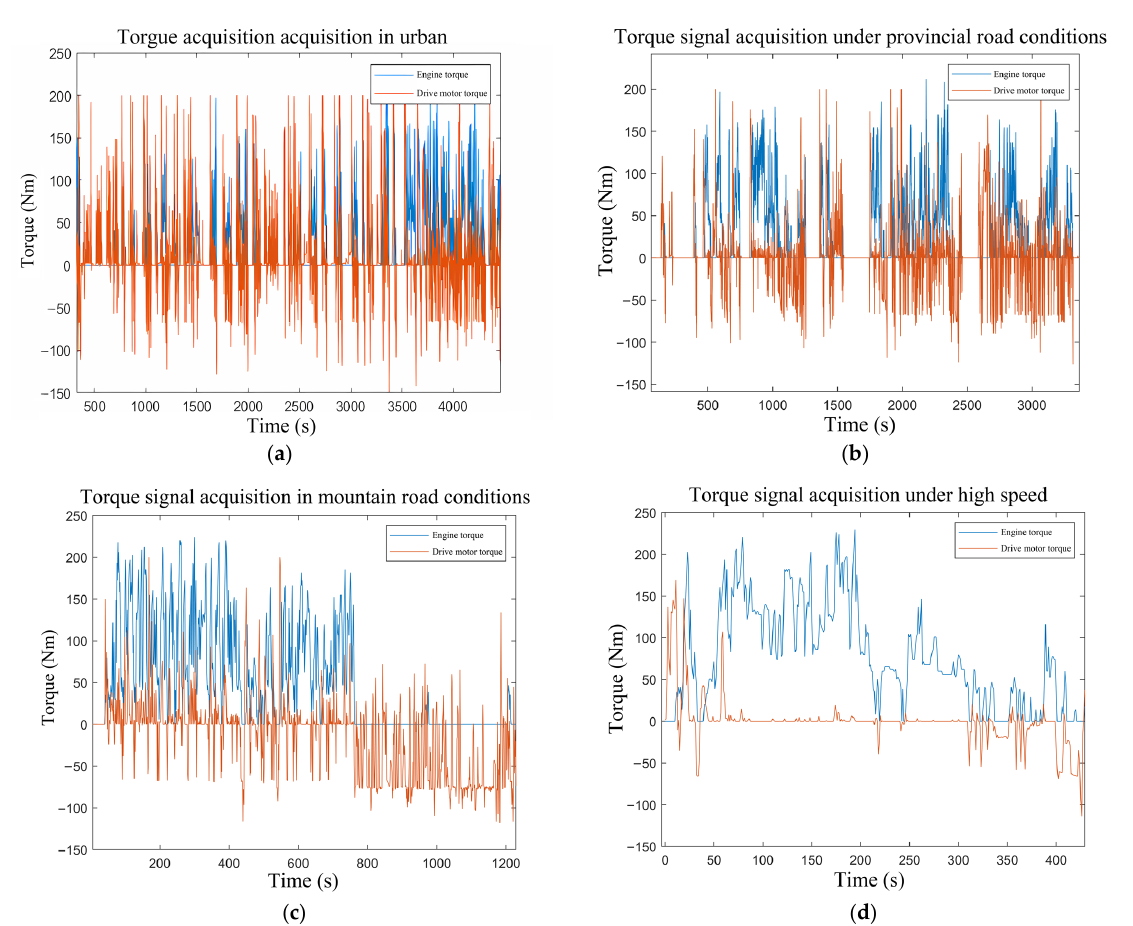
Figure 2. Load time history diagrams under different working conditions, they are listed as follows: ( a ) load time history under urban working conditions, ( b ) load time history under provincial road conditions, ( c ) load time history under mountain road conditions, and ( d ) load time history under high-speed conditions.